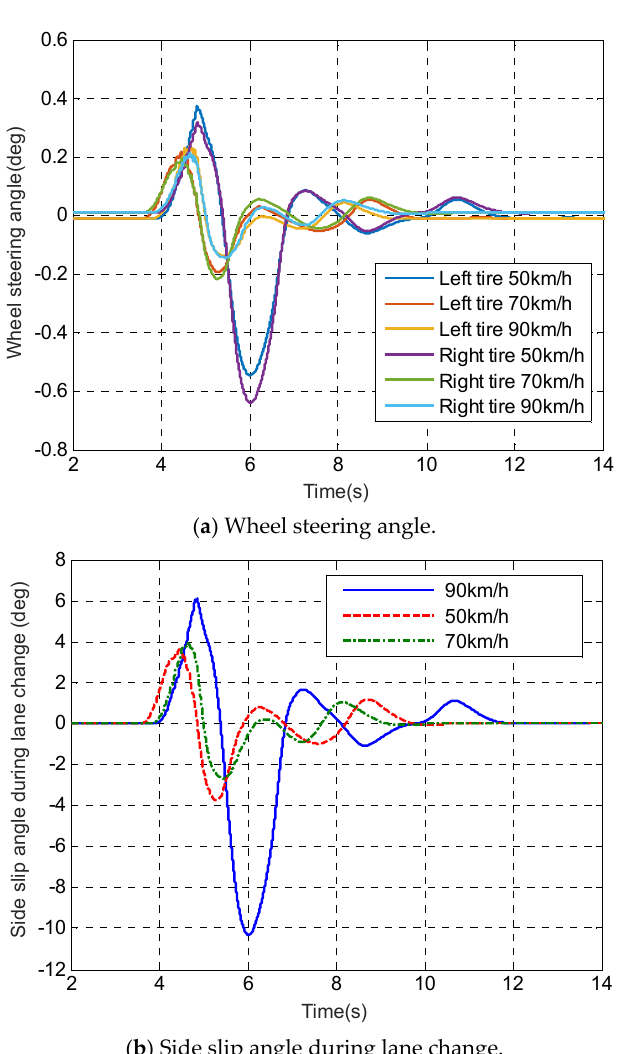
Figure 10. Wheel steering angle and side slip angle.